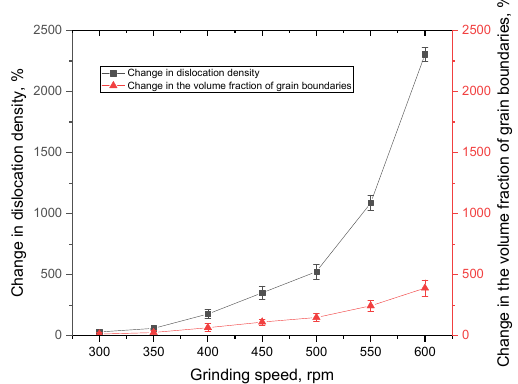
Figure 5. Evaluation results of the efficiency of the dislocation density and the volume fraction of grain boundaries change depending on grinding conditions. As can be seen from the data presented, the greatest change in size affects the change in dislocation density, which, when the grain size decreases to 100 nm, leads to a sharp increase in dislocation density (more than five times higher than the change in the vol ‐ ume fraction of grain boundaries). These differences can be explained by the fact that as the grain size decreases, the dislocation density, which has an inversely quadratic de ‐ pendence on the size, sharply increases due to the small size, while the volume fraction has a more complex size dependence, which also includes the dimensions of the bound ‐ aries themselves. 3.2. Study of the Influence of Grain Sizes on the Hardening of Ceramics One of the important factors that are key in this study is the determination of the efficiency of changing grain sizes in hardening ceramics to external mechanical influ ‐ ences under single compression, as well as determining the hardness of ceramics. As is known, a decrease in grain size can lead to the creation of additional barriers to the propagation of microcracks under external influences, which also increases the crack re ‐ sistance. To measure the mechanical and strength properties, the obtained powders were pressed into tablets with a diameter of 8 mm and a thickness of 2 mm, which were sub ‐ jected to further tests. To determine the changes in hardness, the indentation method was